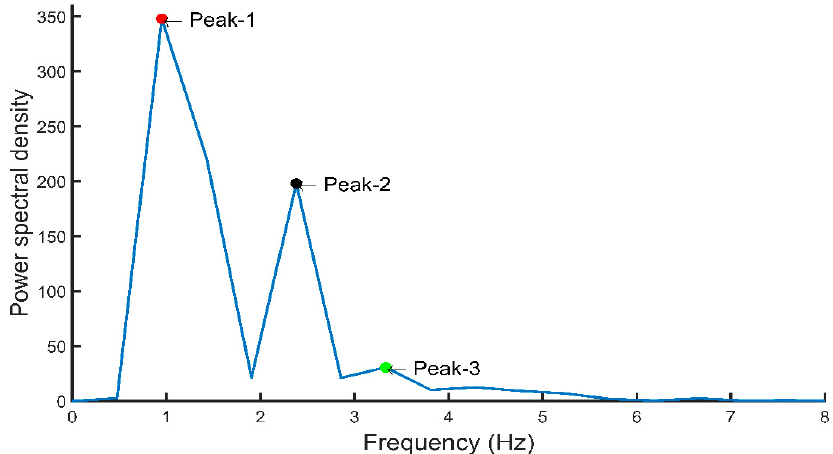
Figure 12. Frequency-domain representation of PPG signal with important features. Table 2. Twenty-four features from the PPG signal.